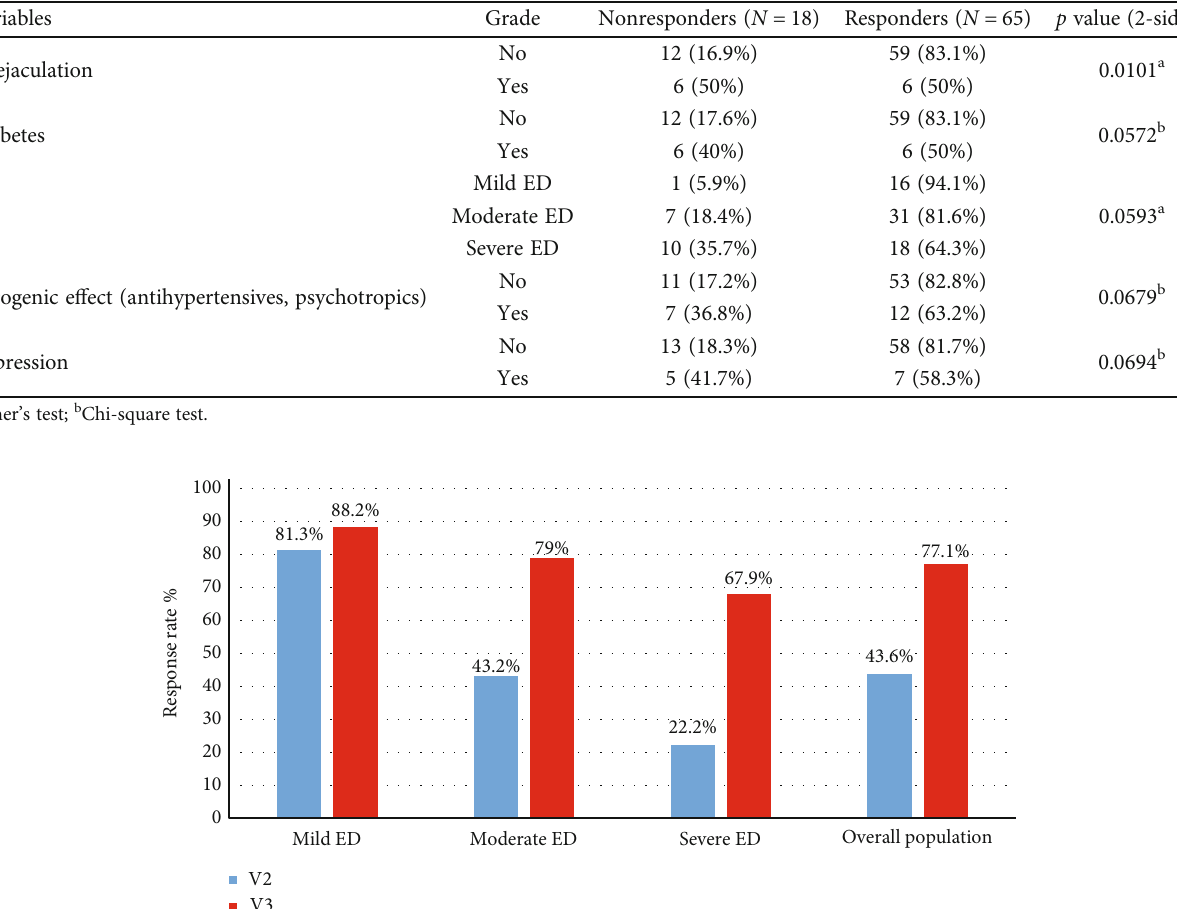
Figure 2: Response rate at V3 in each group and overall population. Group 1 (mild); Group 2 (moderate); Group 3 (severe) ED; Group 4 (previous treatment with other PDE5-Is). Table 2: Characteristics and laboratory parameters of the study population. The laboratory values of patients were classi fi ed as “ normal ” or “ abnormal ” according to the reference values of each centre.